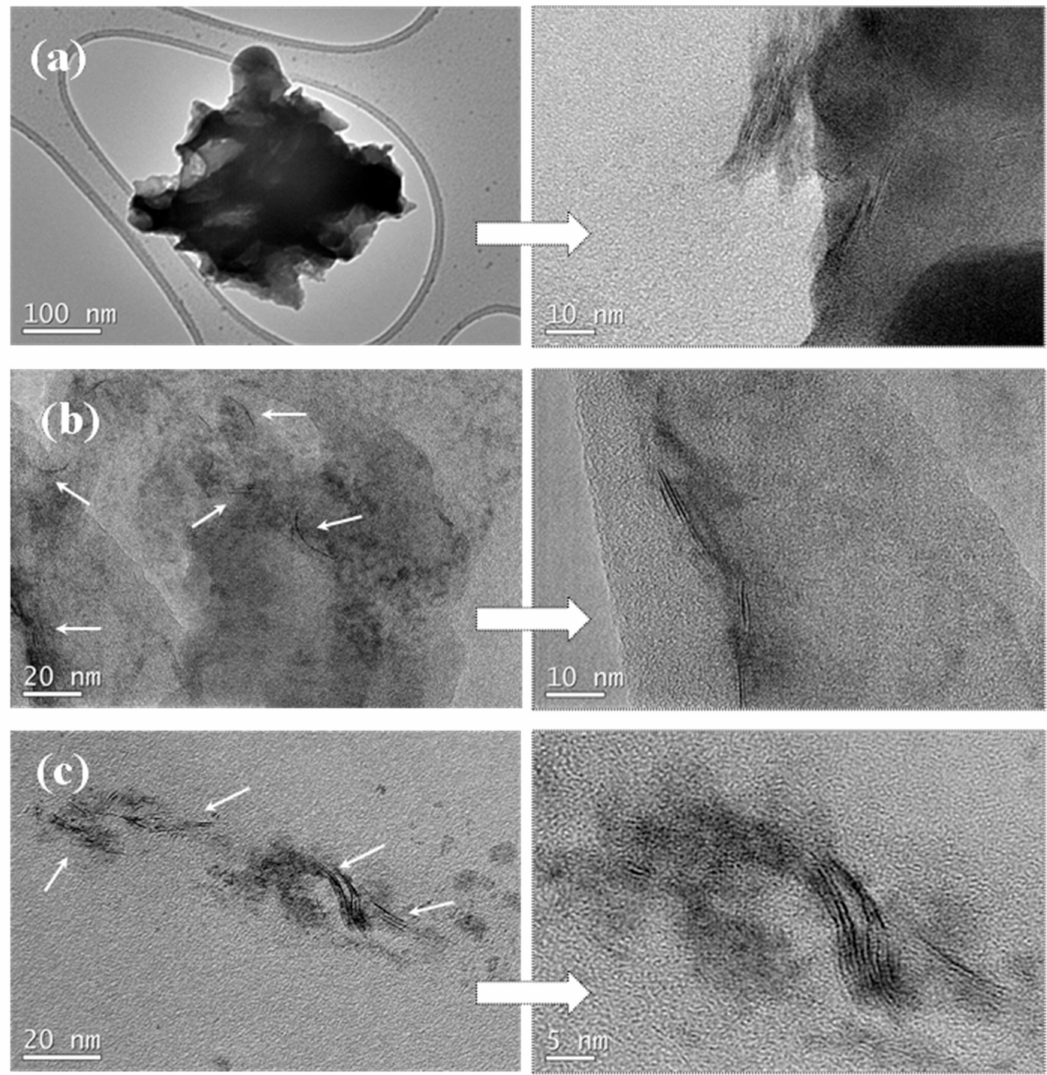
Figure 2. High-resolution SEM micrographs of ( a ) 2D-WS 2 and PLLA/2D-WS 2 nanocomposites with nanofiller loadings of ( b ) 0.1 and ( c ) 1.0